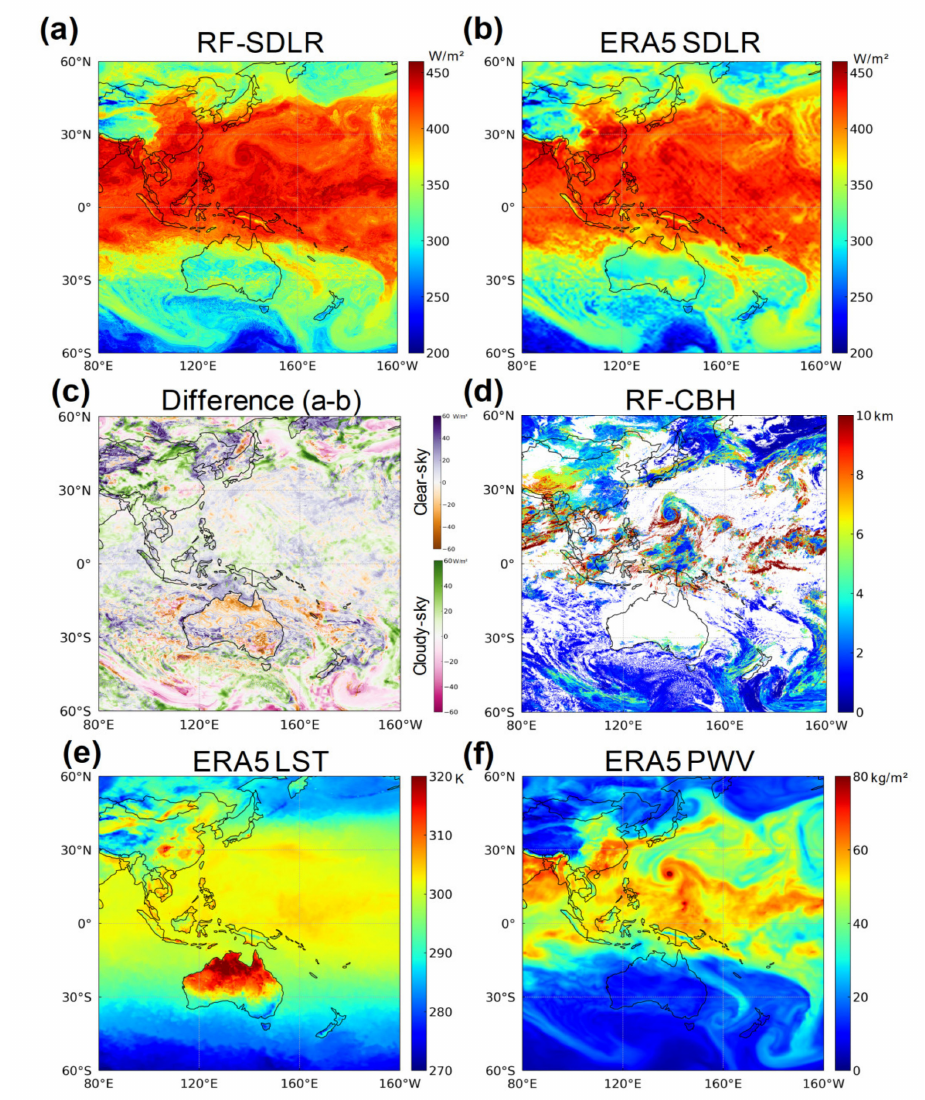
Figure 7. Spatial features of the H-8 full-disk SDLR and RF inputs on 1 September 2018: ( a ) H-8 SDLR derived using RF models; ( b ) ERA5 reanalysis SDLR product; ( c ) the difference between H-8 SDLR and ERA5 reanalysis SDLR product under cloudy-sky and clear-sky conditions; ( d ) H-8 CBH derived using the RF models; ( e ) ERA5 reanalysis LST product; and ( f ) ERA5 reanalysis PWV